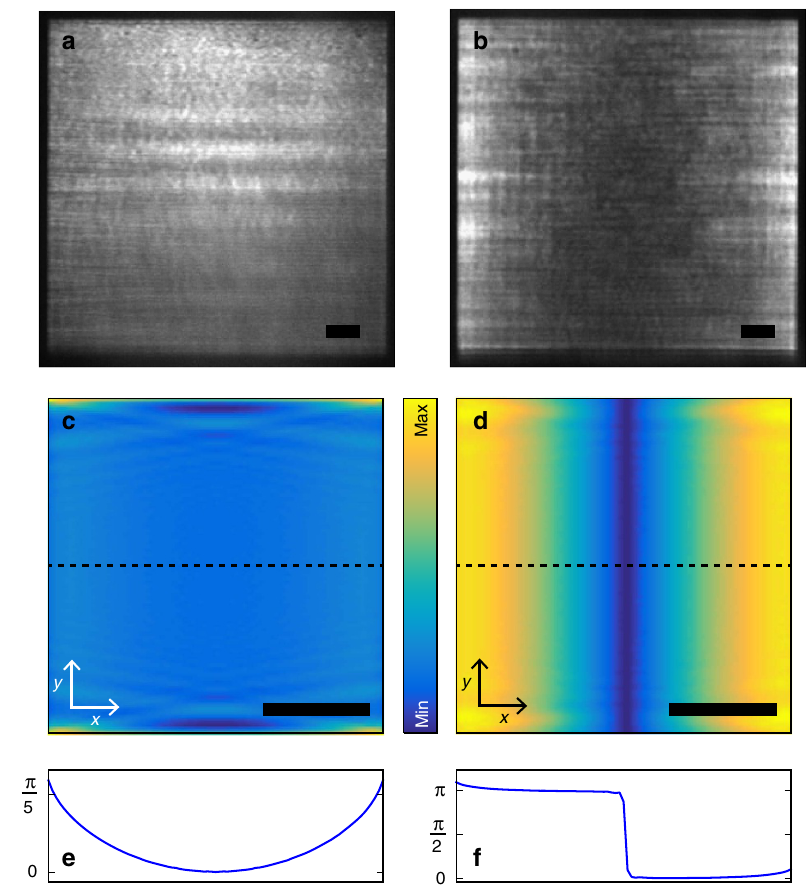
Figure 3 | Real space images of the lasing action and multipole expansion of scattering for y -polarized planewave. ( a – b ) Examples of experimentally observed real space images of the lower ( a ) and upper ( b ) energy lasing modes from two different samples. ( c – d ) Magnitude of the dipole moments (indicated by the colour bar) as a function of position in an array of 85 (cid:2) 85 silver nanoparticles, computed using a multipole expansion method without a gain medium 43 , at lower ( c ) and higher ( d ) mode energies. The calculated phase of the dipole moments along the dashed lines for both modes are shown in e , f . The scale bars in a – d are 10 m